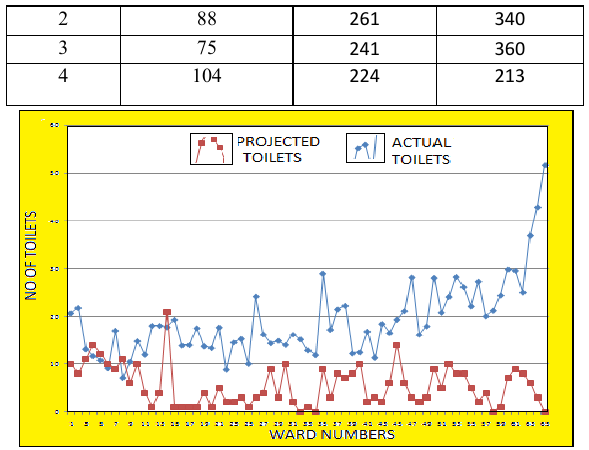
Fig 6: Adequacy analysis of Public Toilets in Each Ward